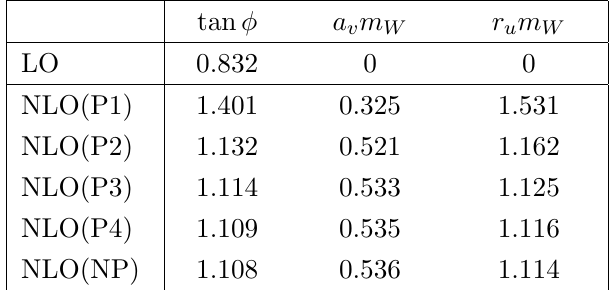
Table 1 . Parameters of ZREFT for (cid:11) = 0 and (cid:14) = 170 MeV at unitarity. The parameters a v and r u , which have dimensions of length, are made dimensionless by multiplying by m W = 80 : 4 GeV. The LO parameter is determined by matching the e(cid:11)ective range r 0 with results from NREFT. The NLO parameters are determined by also matching dr 0 =d(cid:13) 0 and s 0 .